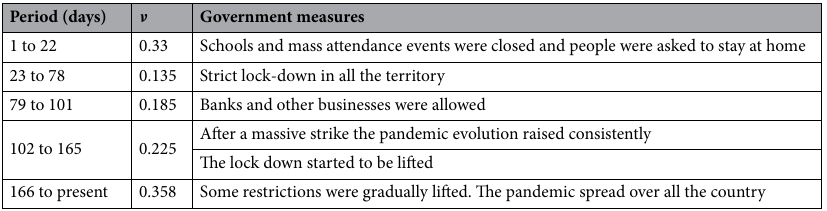
Table 2. Mobility according to government